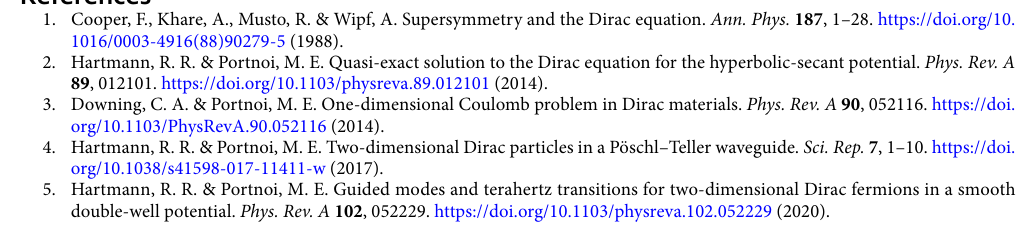
Figure 5. The energy spectrum of confined states in the hyperbolic secant potential V ( x ′ ) 3.2 , as a function of (cid:31) for the s strength V 0 = graphene sheet), depicted by the red and blue lines, respectively. The waveguide is orientated at θ the tilted Dirac material is defined by parameters v x at which the bound states merge with the continuum is denoted by the grey dashed lines. The shaded area represents the energy range for which full valley polarization can be achieved for a given value of (cid:31)